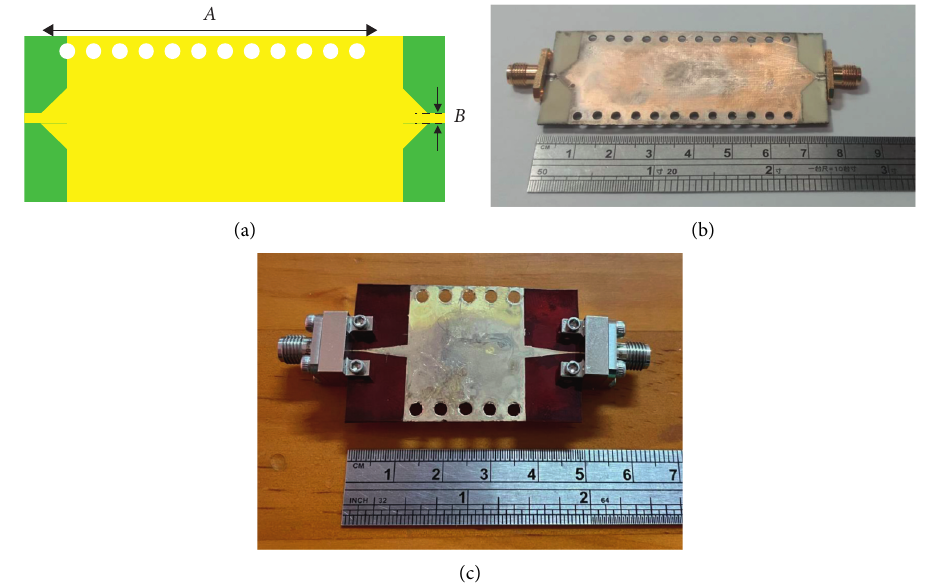
Figure 4: (a) The geometry of the fully inkjet-printed SIW and the photographs of the test piece fabricated on (b) RO4003 C and (c) PI.